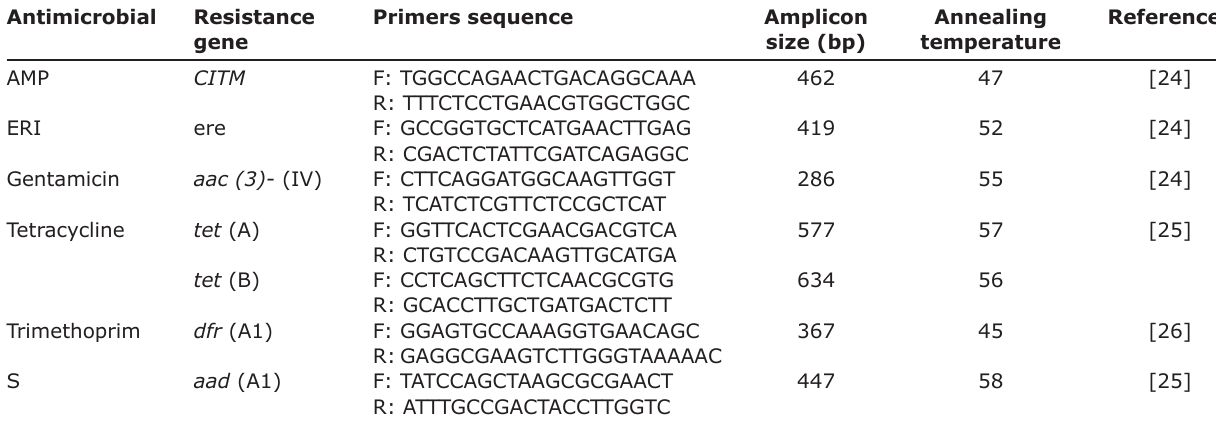
Table-1: PCR primers, amplicons size, and temperature conditions used for the detection of antimicrobial resistance genes. Antimicrobial